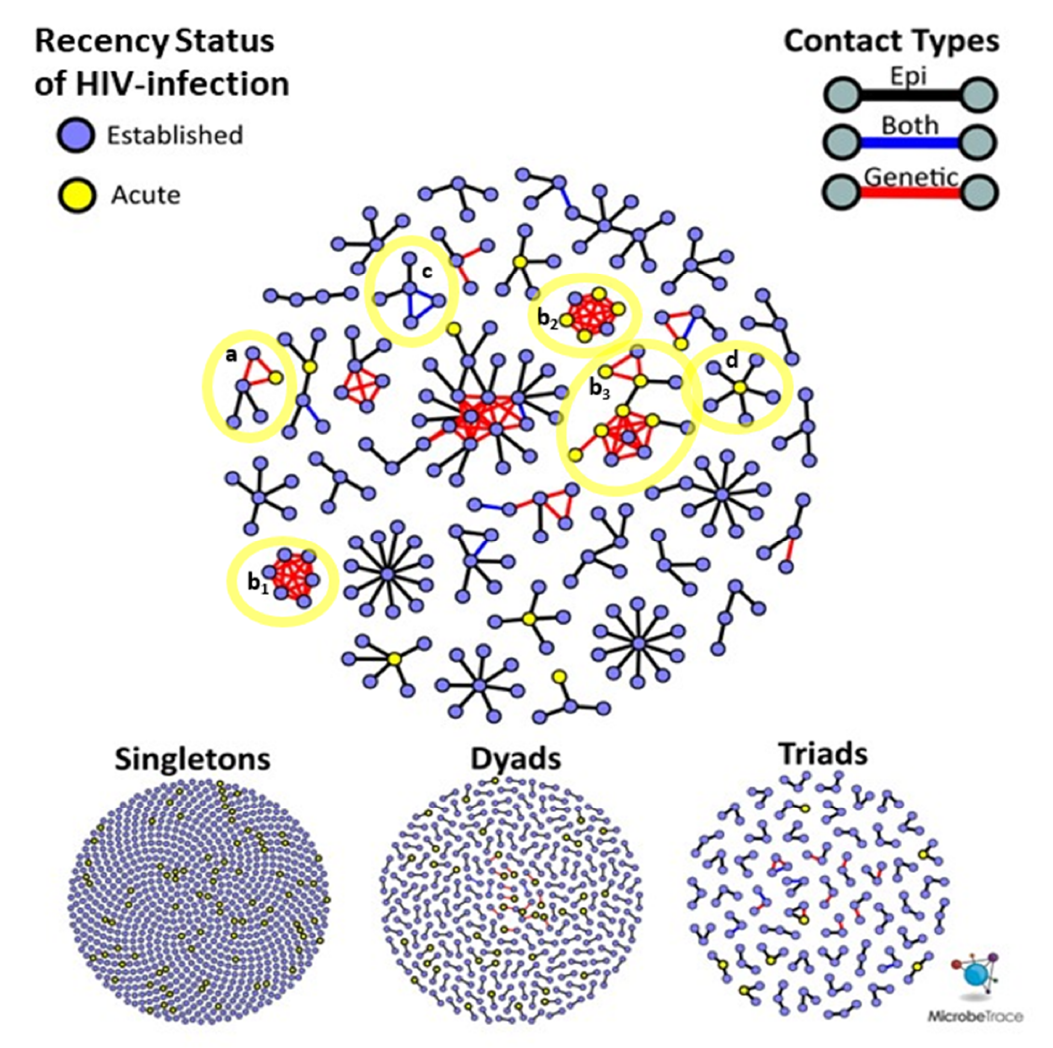
Figure 3. Superimposed risk networks and genetic clusters in three HIV study sites (North Carolina, San Francisco and New York City, stratified by cluster size. Network of all sexual contacts reported between participants and their partners diagnosed with HIV visualized using MicrobeTrace (http: // microbetrace.cdc.gov); uninfected partners are not shown. A force-directed layout algorithm was applied to sort clusters by increasing size. Links are colored by contact type, ‘genetic only’ links in red, ‘epi only’ links in black and ‘both’ genetic and epi links in blue. Individuals are represented as circles, colored by recency of HIV infection. Blue circles represent established HIV-infection and yellow circles represent acute HIV-infection (AHI). Select clusters of interest are highlighted in yellow and labeled: Cluster (a) contains members in San Francisco and New York City. Clusters (b 1 ), (b 2 ) and (b 3 ) consist primarily of members that did not name any high-risk contacts, where the majority of members of clusters (b 2 ) and (b 3 ) were diagnosed with acute HIV infection. Cluster (c) membership consists of two females who named each other as contacts and whose viruses are linked by a close genetic distance ( d ≤